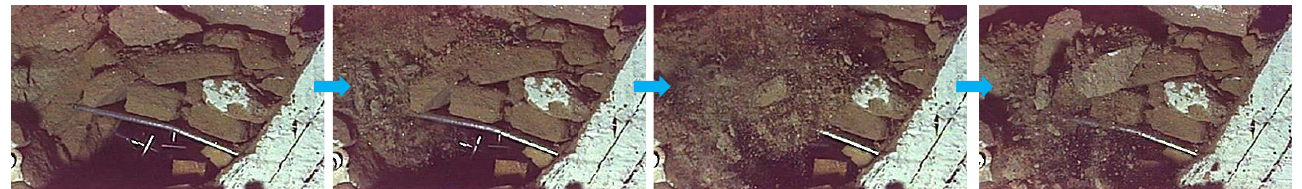
Figure 7. High-speed camera image of coal rock impact appearance.